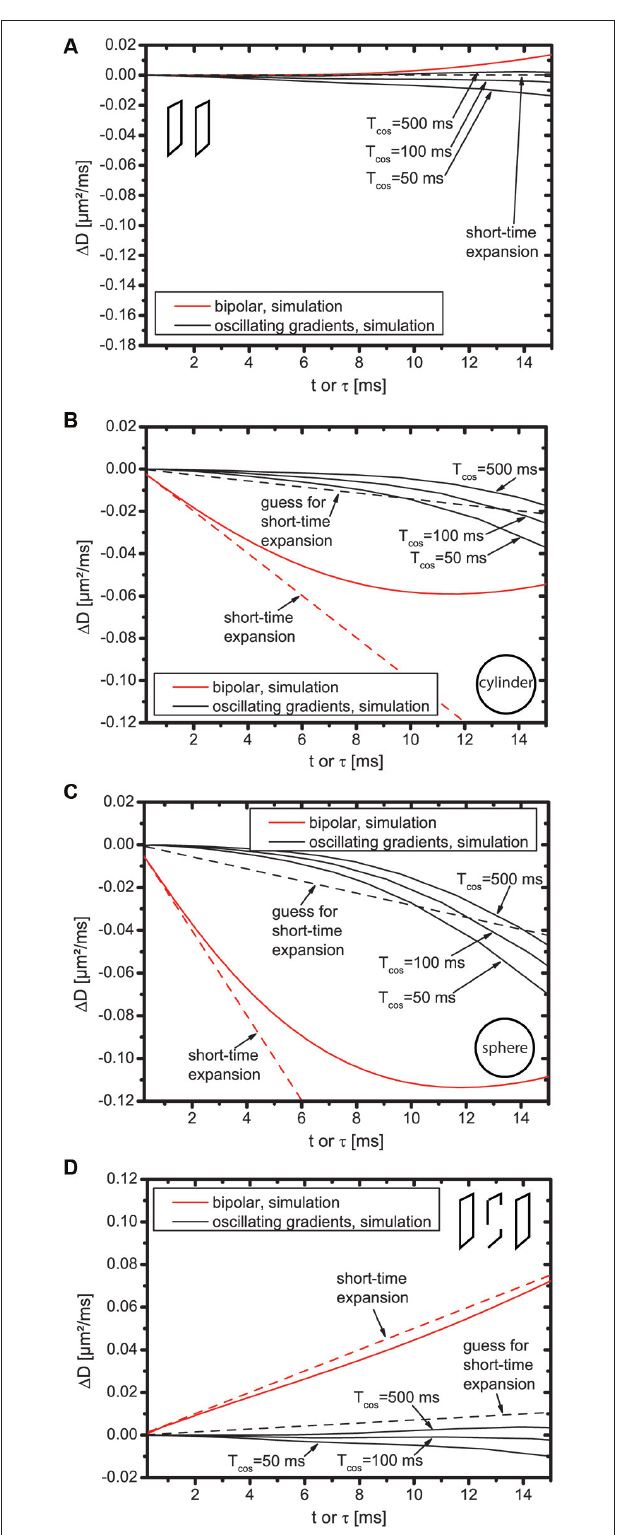
FIGURE 2 | Difference between simulated diffusion coefficients and first order short time diffusion expansion for slab domain (A) , cylinder (B) , sphere (C) , and bi-slab (D)